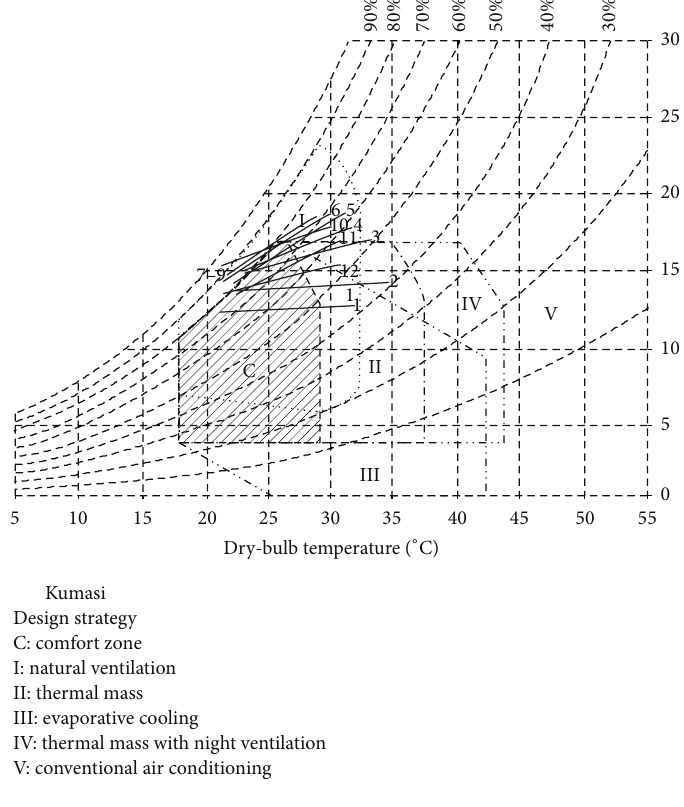
Figure 1: Building Bioclimatic Chart of Kumasi